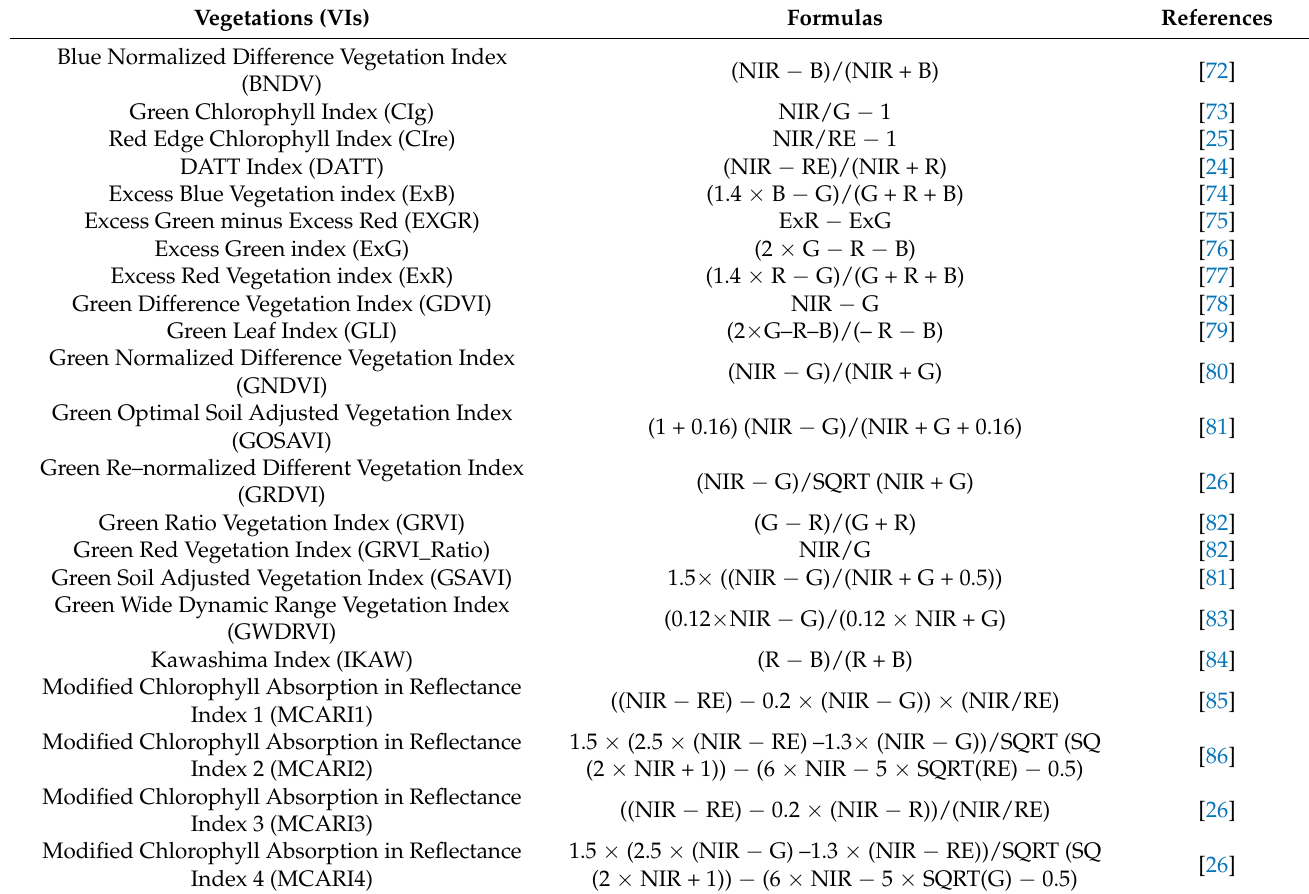
Table A1. The vegetation indices evaluated in this study, B, G, R, RE, and NIR, indicate blue, green, red, red edge, and near-infrared band